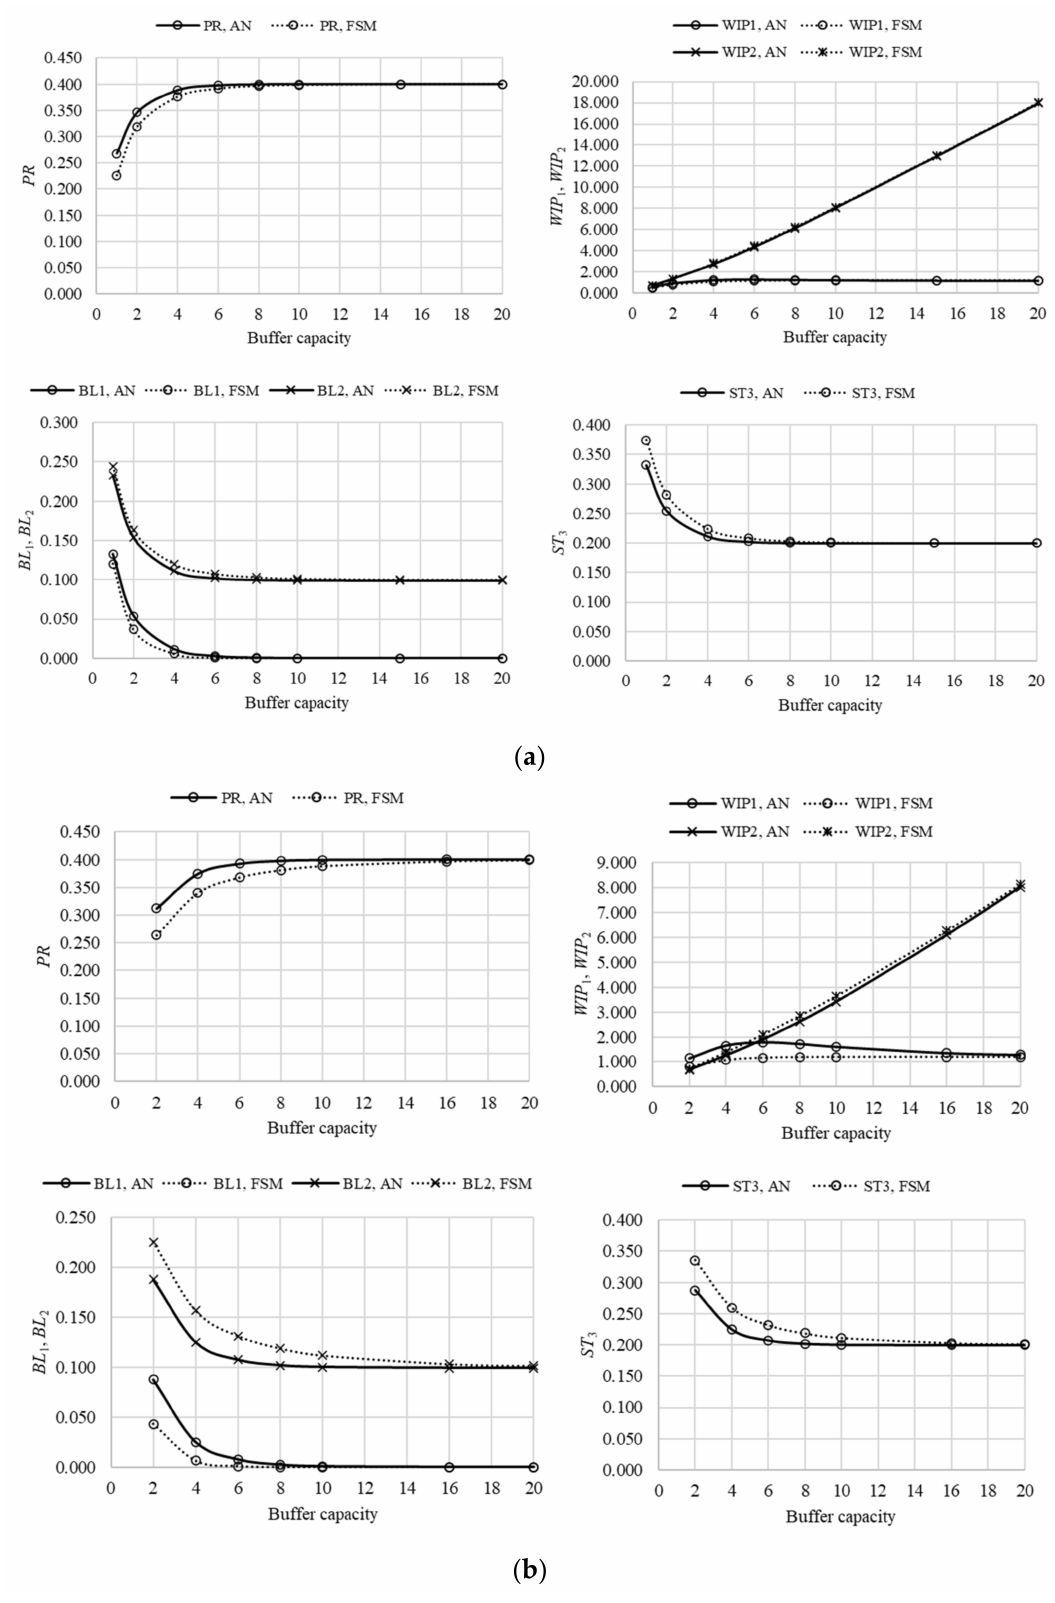
Figure 5. Comparison of the performance measures in the case of line L3: ( a ) N 1 = N 2 = N ; ( b ) N 1 = N , N 2 = 1 / 2 N